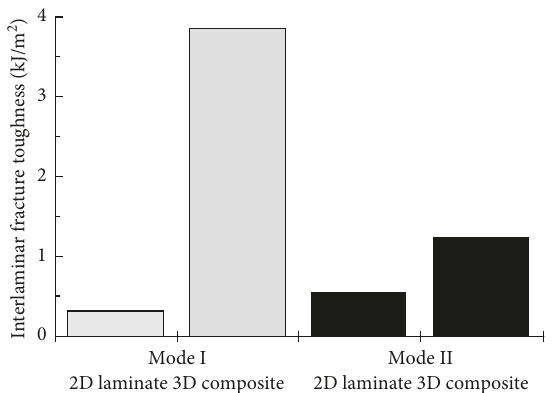
Figure 3: Interlaminar resistances at rupture modes I and II of composite materials made with stacked 2D fabrics and 3D warp interlock fabrics [21].